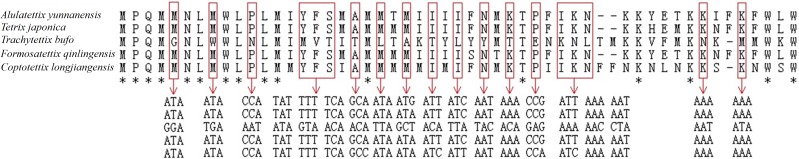
The varied amino acid and corresponding nucleotide sequences of atp8 gene in five Tetrigidae mitogenomes.